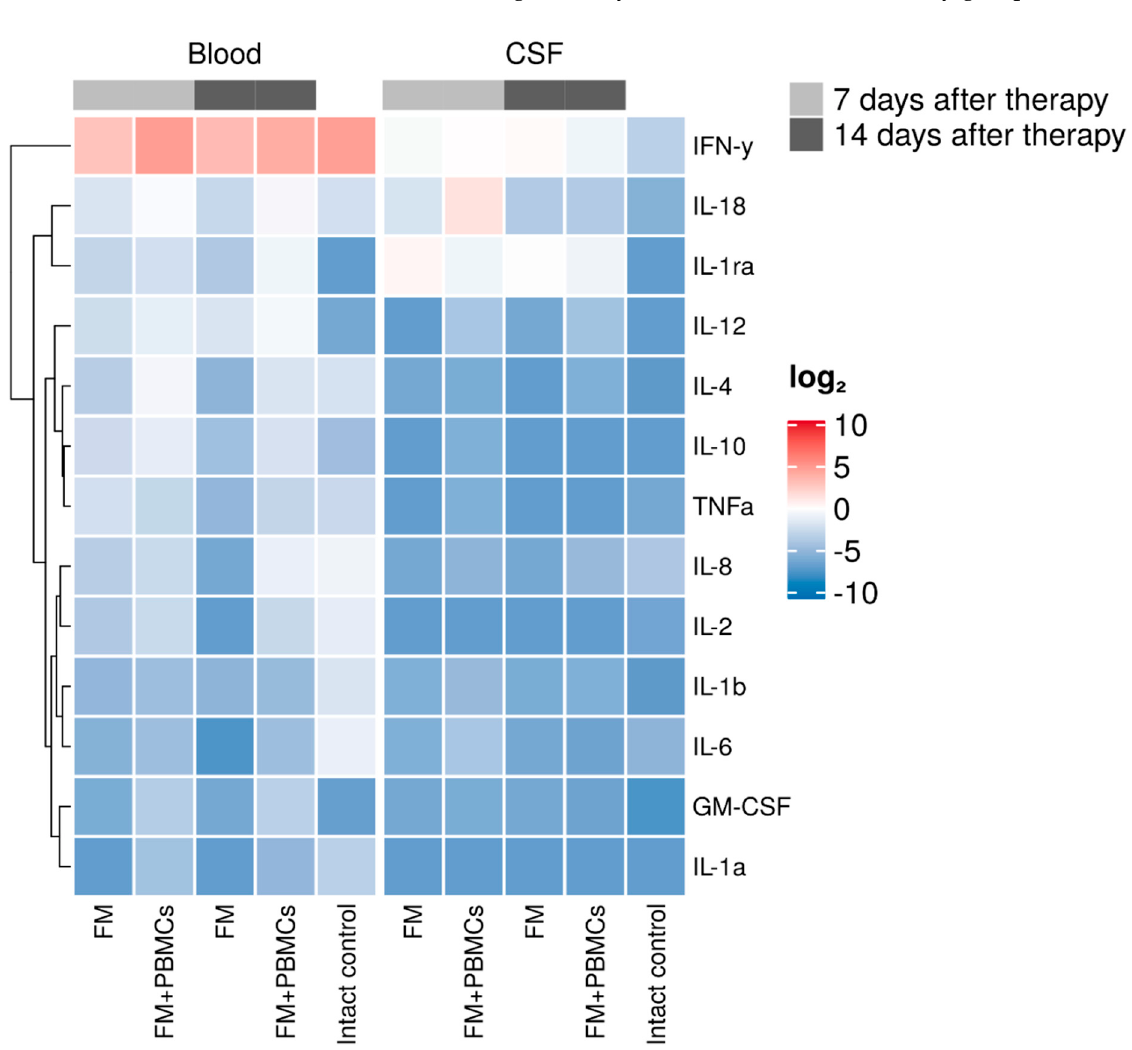
Figure 6. Heat maps showing cytokine/chemokine log10 concentrations, generated with the multiplex analysis of blood serum and cerebrospinal fluid before and after spinal cord injury in the study groups. Cytokine/chemokine profile on days 7 and 14 after FM or FM+PBMCs application (5 pigs in each group). A dendrogram resulting from hierarchical clustering of cytokines is shown on the left.